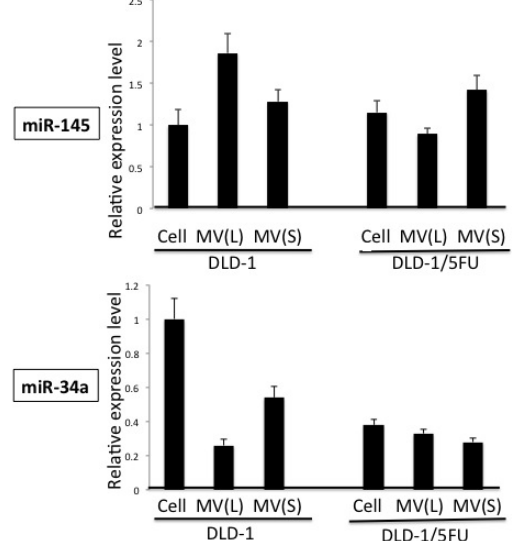
Figure 2. Tracing EU-labeled miR-145 and -34a from donor cells into MVs. Amounts of EU-labeled nascent miR-145 and -34a in DLD-1 and DLD-1/5FU cells and in their secreted MVs are shown. The relative quantities of EU-labeled miRNA are given, with the amount of the expression in DLD-1 cells indicated as “1”. The results are presented as the average value of three independent experiments. MV(L) and MV(S) are MVs filtered through the 1st filter and 2nd filter, respectively, of the ExoMir